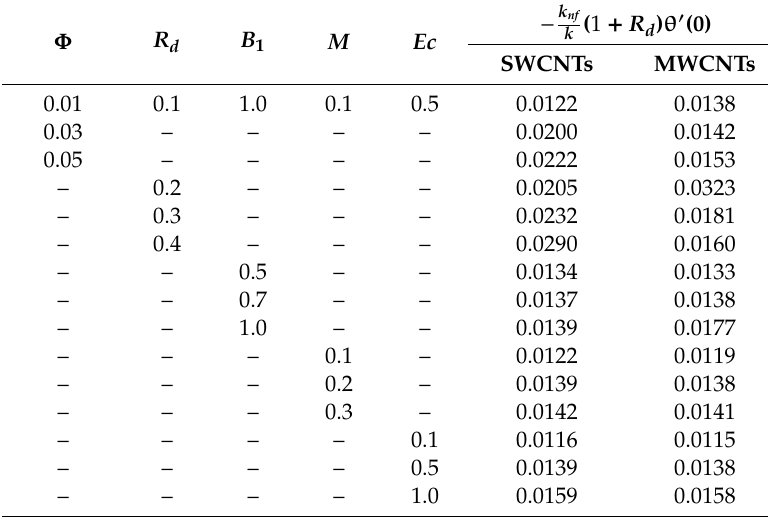
k nf ( 1 + R ) θ (cid:48) ( 0 ) di ff erent evaluations of various parameters. d k